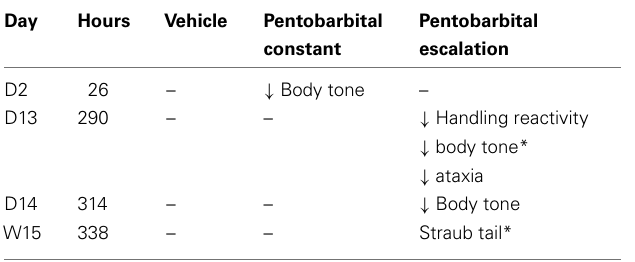
Table 2 | Clinical signs observed during dosing and withdrawal following pentobarbital and vehicle.